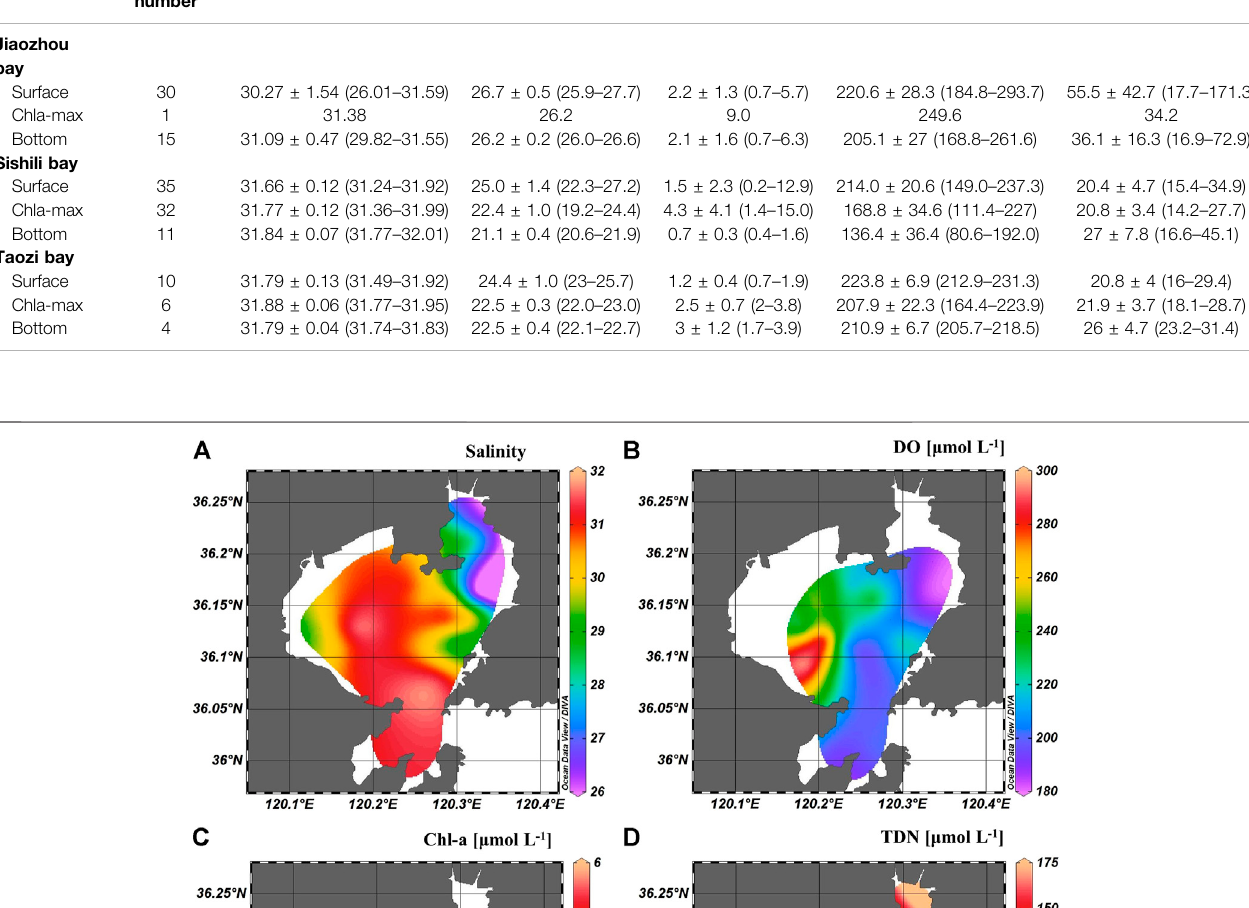
Frontiers in Earth Science |